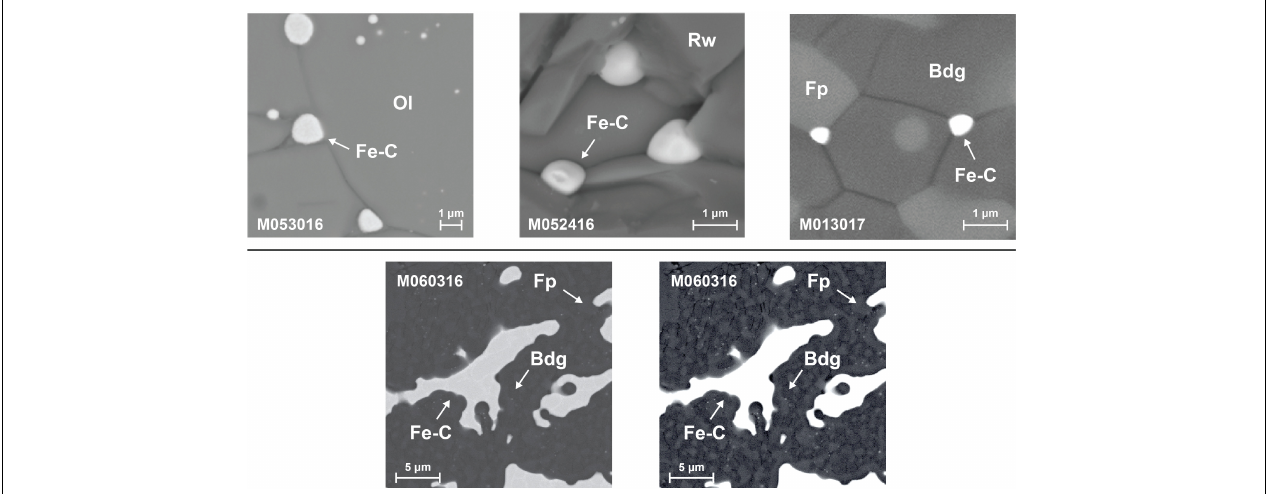
FIGURE 2 | Back scattered electron (BSE) image of the experimental products. Upper: products showing Fe–C melt (gray) dispersed in olivine (Ol) in M053016, ringwoodite (Rw) in M052417, and bridgmanite (Bdg) and ferropericlase (Fp) in M013017. Lower: product of experiment M060316 showing Fe–C melt (gray with dendritic texture on the left, bright on the right) in a matrix of bridgmanite (Bdg) and ferropericlase (Fp). Some Fe–C melt partially connected to form larger domains but small melt pockets remain trapped in the solid matrix.